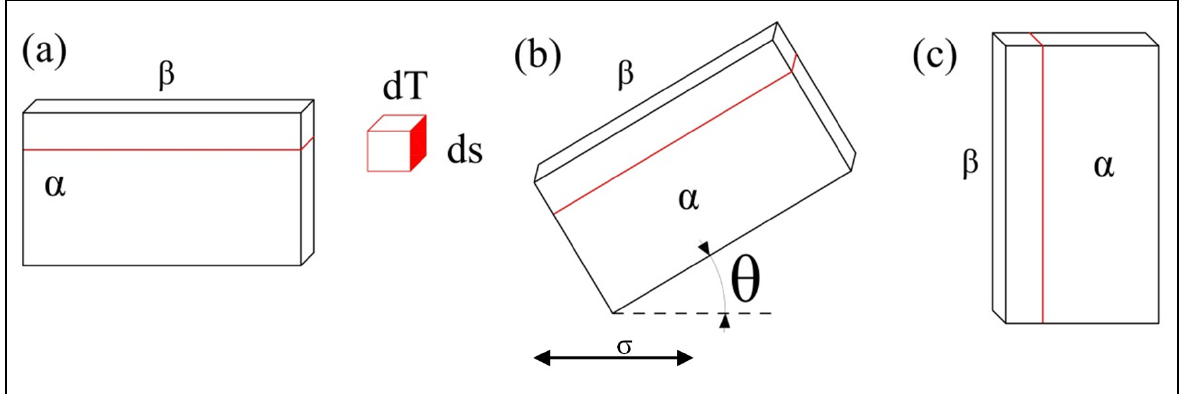
Figure 11. Schematic illustration of ( a ) the interface parallel to the stress axis, ( b ) the interface with an angle ( θ ) to the stress axis, and ( c ) the interface perpendicular to the stress axis.